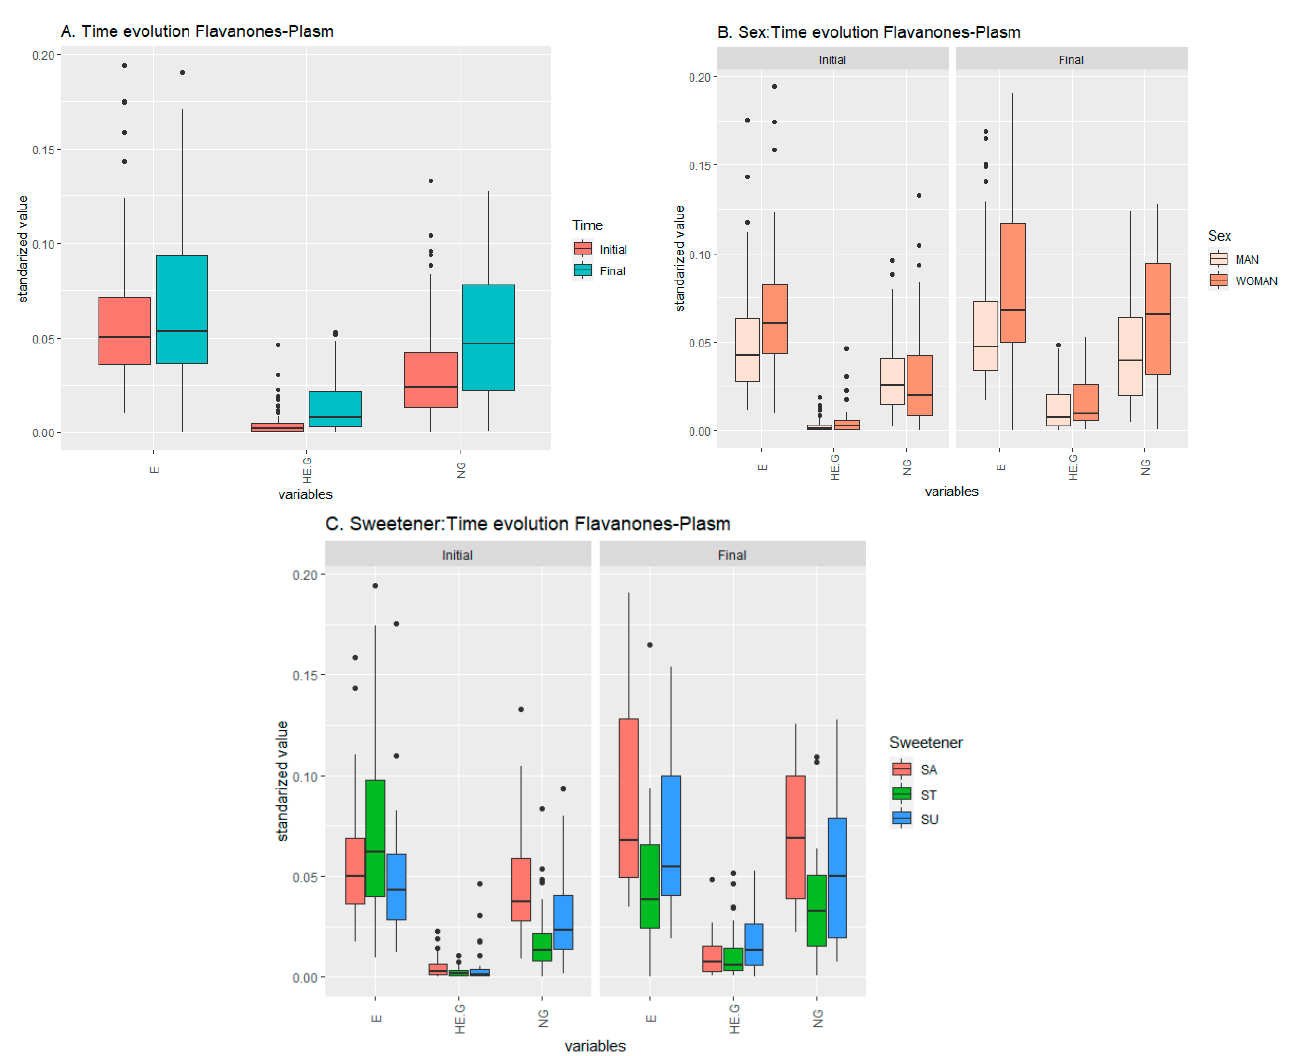
Figure 2. Temporal evolution of the effects of the beverage over the response (metabolic values) in the flavanones plasma set. ( A ) Effect of the beverage over time, ( B ) effect of the interaction sex–time, ( C ) effect of the interaction sweetener–time.